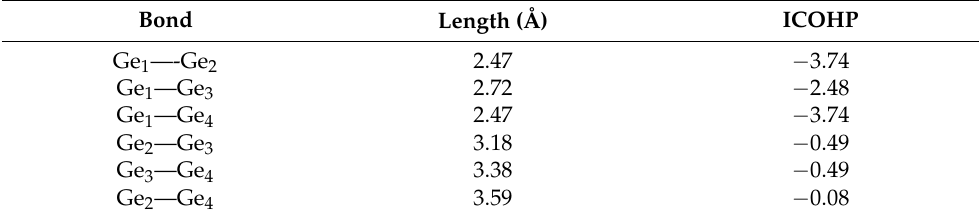
Table 2. Bond lengths (Å) and ICOHP values of Ge-Ge bonds in 1LG/Ge/SiC with a 7/8 BL coverage.